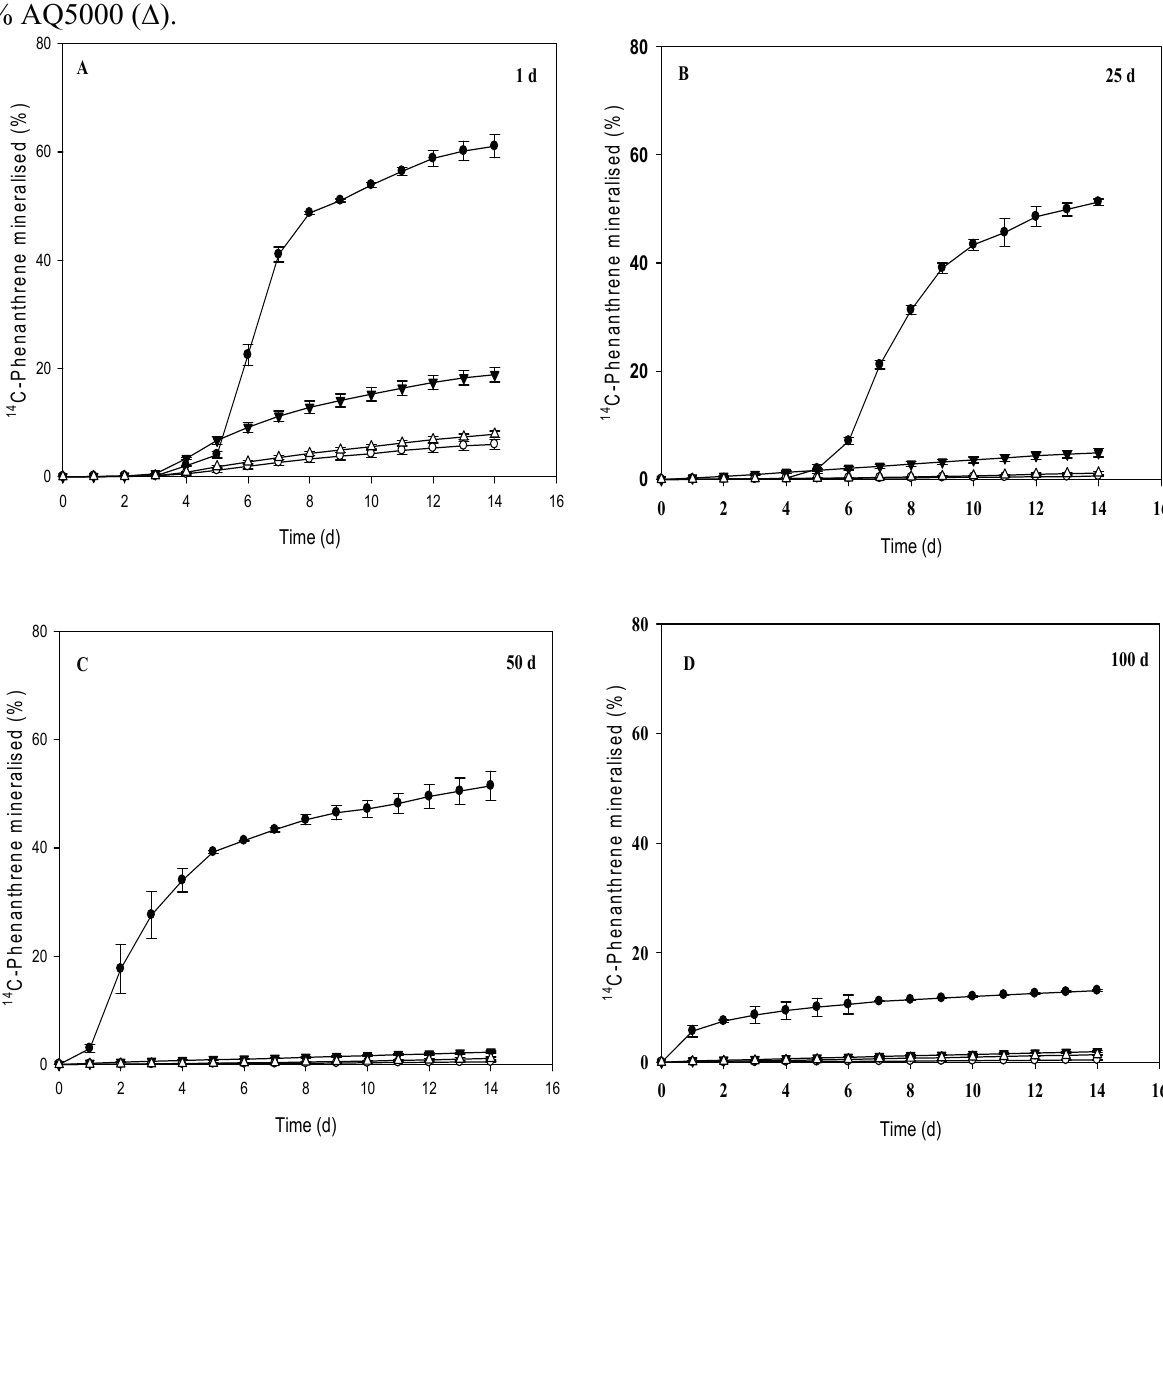
Figure 1. 14 C-Phenanthrene mineralisation by indigenous microorganisms in non-sterile Myerscough soil after AC addition at contact time: ( A ) 1 d ( B ) 25 d ( C ) 50 d ( D ) 100 d. Error bars are SEM ( n = 3). Legend key: 0% ( ● ), 1% CP1 ( ○ ), 1% CB4 ( ▼ ) and 1% AQ5000 ( ∆